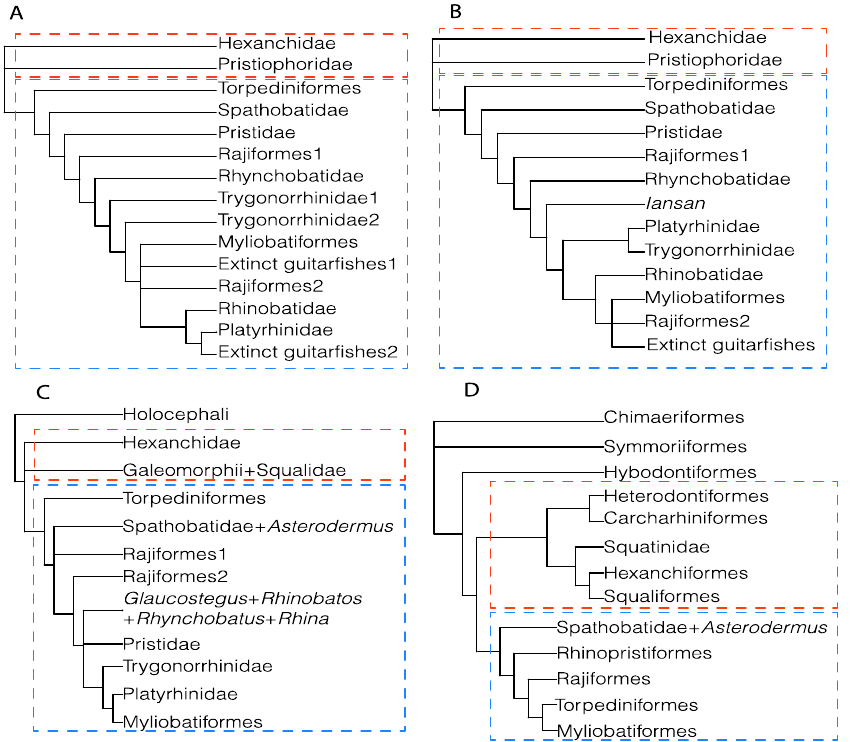
Figure 52. Simplified trees form the strict consensus tree from the parsimony analyses of previous works showing the differences in the relationship between the elasmobranch groups. Red rectangle: Selachimorpha; blue rectangle: Batomorpha. ( A ) Underwood and Claeson [24]; ( B ) Brito et al. [116]; ( C ) Marramà et al. [33]; ( D ) Present work. The present analyses also included the species Pseudobatos productus ( Rhinobatos ) and Pseudobatos lentiginosus ( Pseudobatos ) , both exhibiting significant variations in their skele- tal morphologies, especially of their pectoral girdles. These differences contradict their placement in a single genus, supporting the separation of the American Pacific and Atlan- tic “ Pseudobatos ” into different genera. Overall, the present results indicate that the Rhi- nopristiformes are a group still in urgent need of in-depth phylogenetic studies, before any taxonomic rearrangement is proposed. The living ( Raja and Bathyraja ) and fossil († Ostarriraja and † Cyclobatis ) skates are grouped with sclerorhynchoids, which is consistent with previous analyses that recovered this relationship based on features of the branchial skeleton [32,117]. Rajiformes show a rather intriguing suite of morphological characters, which are also present in several bato- morph groups, including rostral appendices (also observed in Rhinopristiformes), cate- nated calcification on the pectoral-fin radials and lack of a postpelvic process (also ob- served in Myliobatiformes). The sharing of these features with guitarfishes and